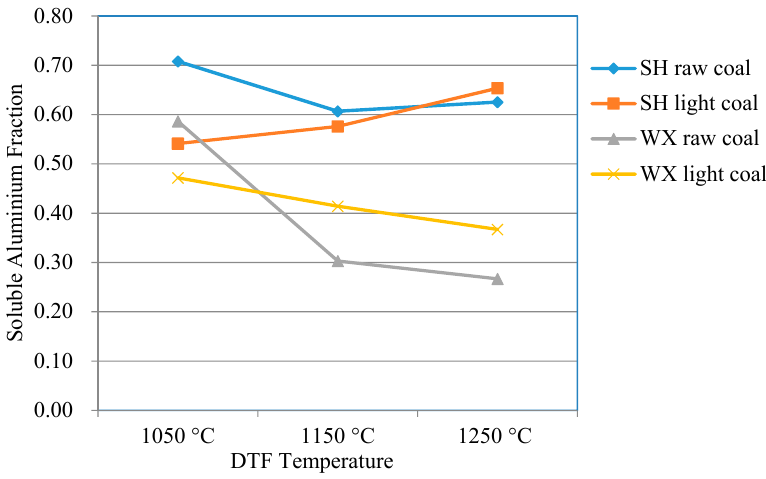
Figure 9. Soluble aluminium fractions in DTF ashes of SH and WX coal.